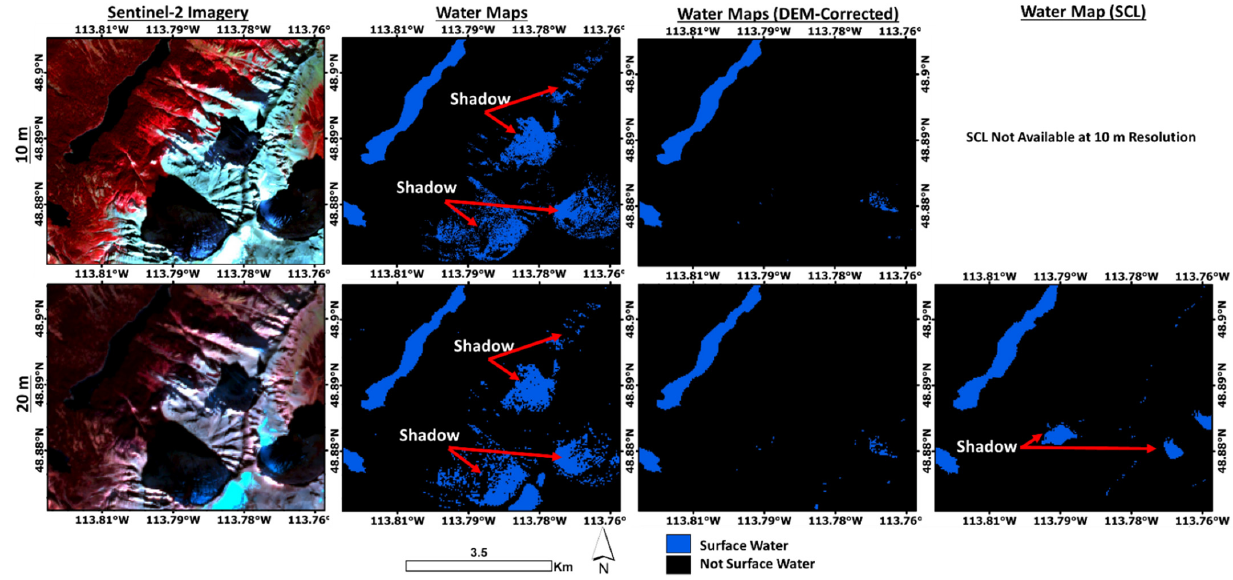
Figure 8. Mountainous area in the T11UQQ granule shown with the 10 m and 20 m imagery. Errors were present in the original output, but were significantly reduced after the DEM post-processing was applied.